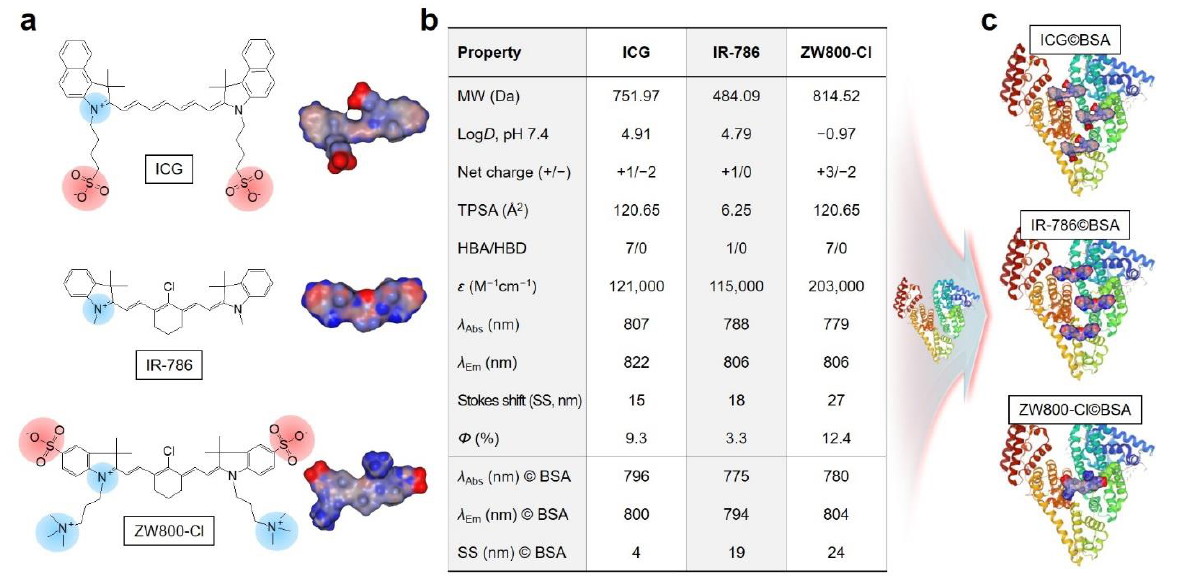
Figure 1. ( a ) Chemical structure, net surface charge, and three-dimensional (3D) modeling of the geo- metrical positions of ICG, IR-786, and ZW800-Cl NIR dyes. Red, negative charge; blue, positive charge; gray, hydrophobicity. ( b ) Physicochemical and optical properties of ICG, IR-786, ZW800-Cl in 100% serum, and their complexes with BSA in PBS at pH 7.4. In silico calculations of the distribution coeffi- cient (log D at pH 7.4), topological polar surface area (TPSA), and hydrogen bond acceptors/donors (HBA/HBD) were performed using Marvin and JChem calculator plugins (ChemAxon). ( c ) Simplified schematic for the formation of each dye©BSA complex.